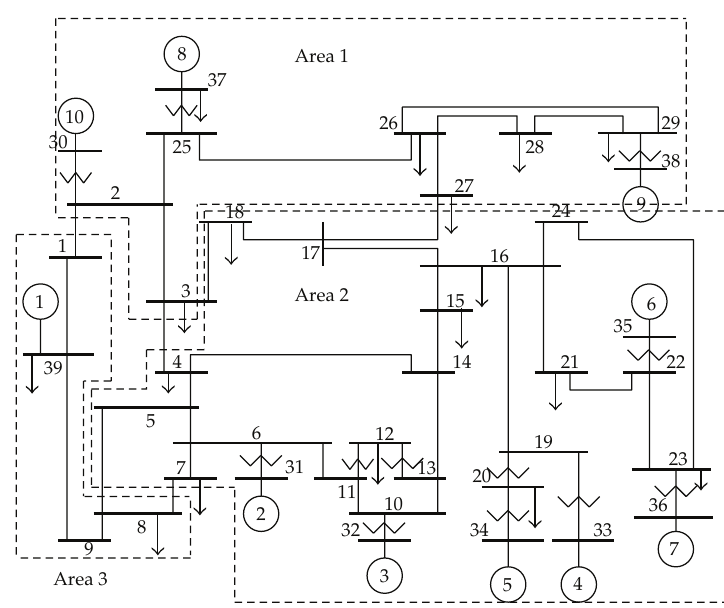
Figure 1: The IEEE 39-bus